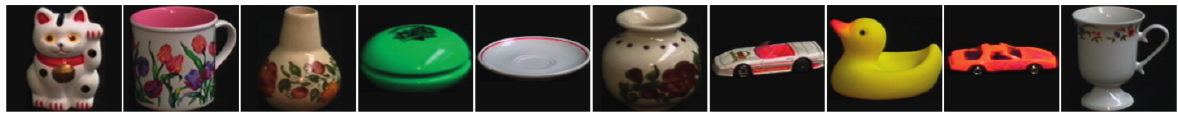
Figure 2. Samples of images from the COIL-100 image